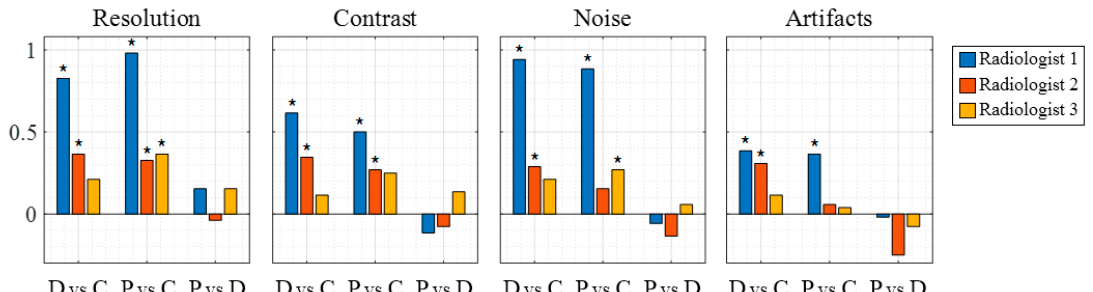
Figure 5. Representative in vivo images of ( a )–( c ) gallbladder, (d)–(f) liver, and (g)–(i) kidney, which were reconstructed by using CF (for (a), (d), and (g)), DWI (for (b), (e), and (h)), and PWI (for (c), (f), (i)). PWI showed better image quality with a 4-fold higher acquisition frame rate than CF and provided a comparable performance with a 2.9 times lower number of computations compared to DWI.